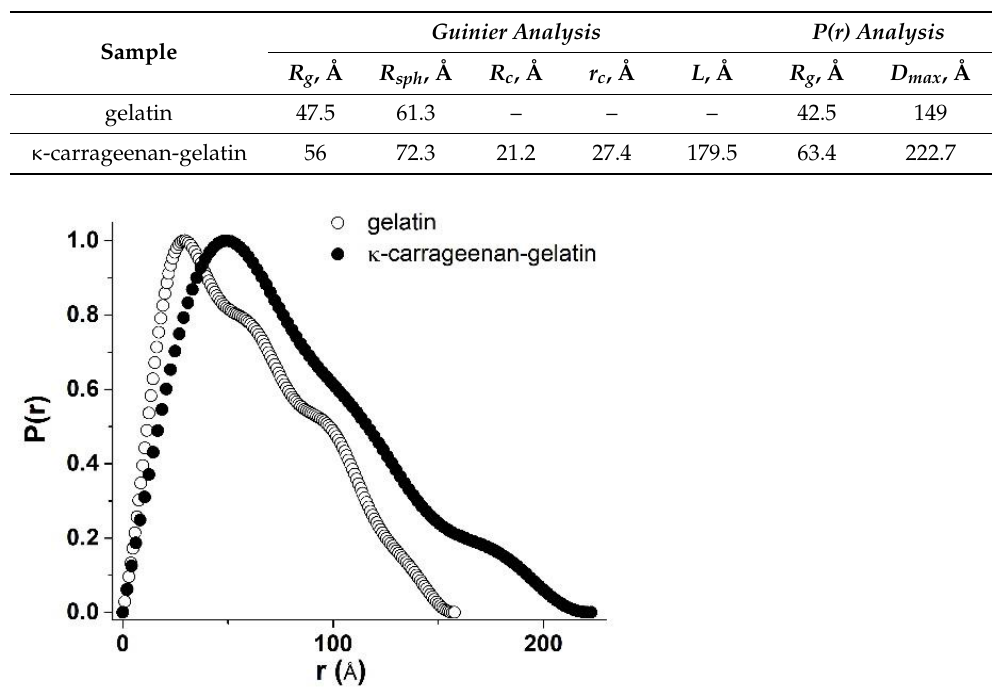
Table 1. Structural parameters for hydrogels at 14 ◦ C.